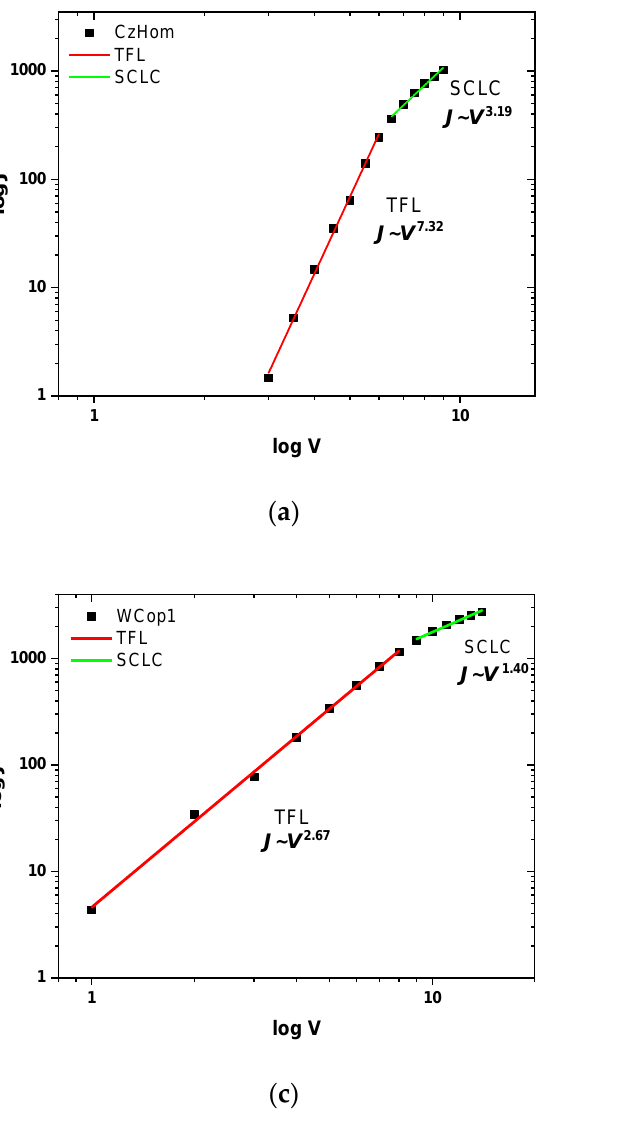
Figure 12. Logarithmic plots of current density-voltage characteristic curves of ( a ) CzHom, ( b ) CzCop, ( c ) WCop1, and ( d ) WCop2 devices with the respective analysis.